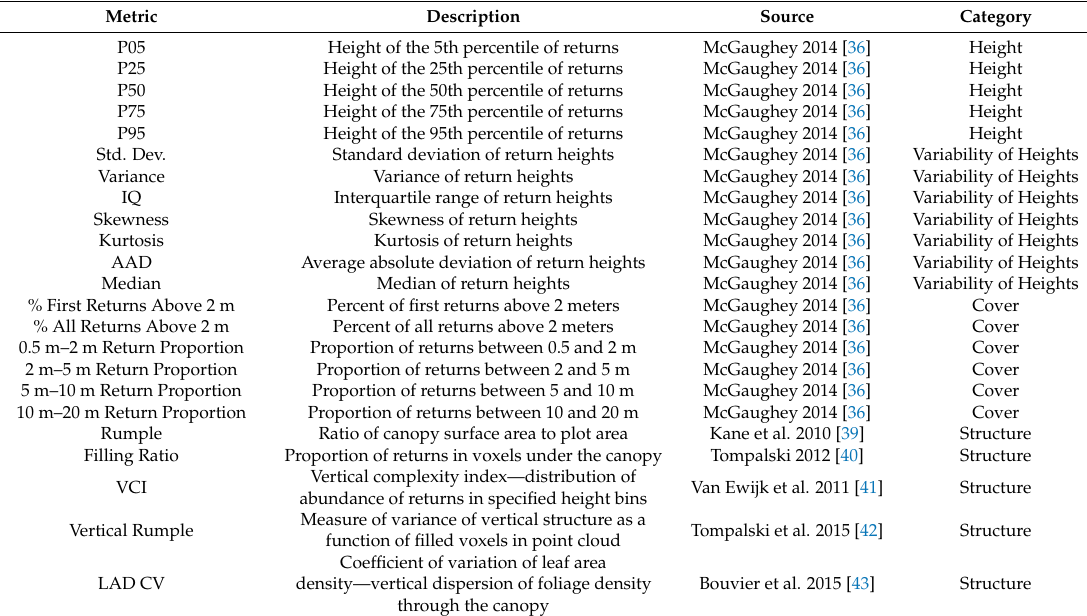
Table 3. ALS metrics used to predict probability density function (PDF)